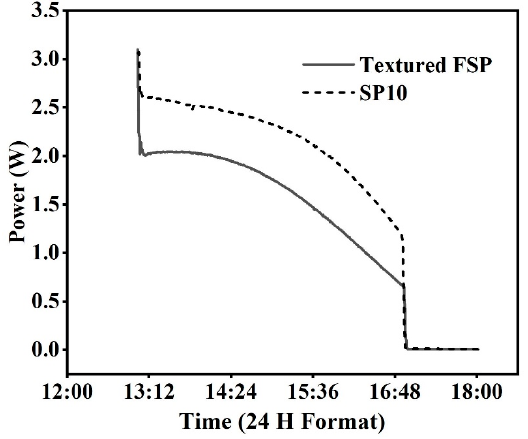
Figure 10. Power generation from SP10 and textured FSP for longer periods.